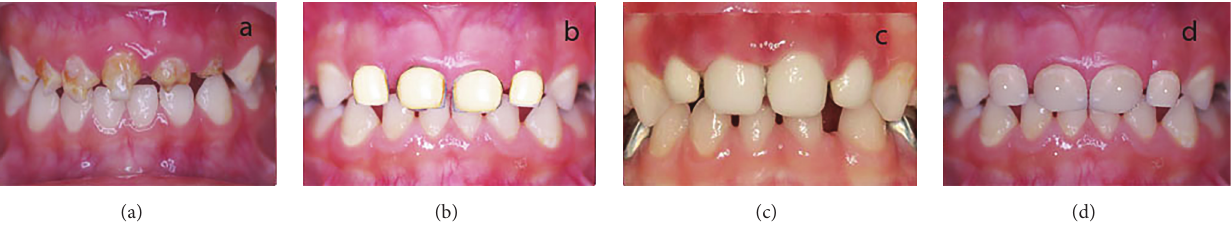
Figure 2: Type of treatment acceptable for deep anterior caries. (a) No treatment, (b) open (resin) faced stainless steel crown, (c) strip crown, and (d) zirconia crown.